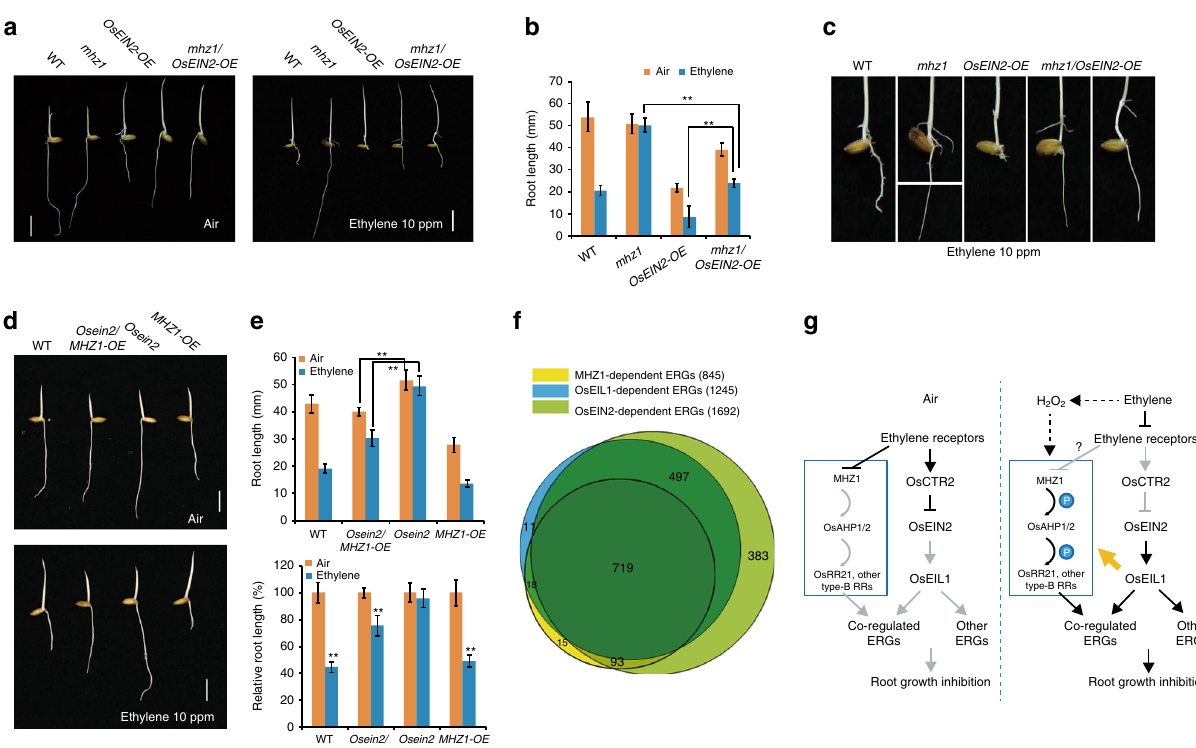
Fig. 5 Genetic interaction of MHZ1 and OsEIN2-mediated pathways. a Ethylene response of mhz1/OsEIN2-OE in comparison with mhz1 and OsEIN2-OE . Bars indicate 10 mm. b Quanti fi cation of root length of the mutants in a . Root lengths are means ± SD, n > 30. ** P < 0.01; Student ’ s t -test. c Enlargement of root features of the mutants treated with 10 ppm ethylene in a . d Ethylene response of Osein2/MHZ1-OE in comparison with Osein2 and MHZ1-OE . Rice seedlings were grown in dark for 2 days with air or 10 ppm ethylene. Bars indicate 10 mm. e Quanti fi cation of root length (above) and relative root length (below) of the mutants in d . Data are means ± SD, n > 30. ** P < 0.01; Student ’ s t- test. f Comparison of MHZ1-, OsEIN2-, and OsEIL1-regulated ethylene- response genes. Etiolated seedlings of WT, mhz1 , Osein2 and Oseil1 were grown for 2 days before treated with air or 10 ppm ethylene for 3 h. Roots were subjected to RNA-seq analysis with three biological replicates. Ethylene-response genes (ERGs) were identi fi ed in WT according to the gene expression levels with at least relative twofold changes ( q -value < 0.05) in ethylene treatment compared to those in the air. A total of 1789 ERGs were identi fi ed. g A proposed working model for MHZ1-mediated ethylene signaling in rice. Rice has the conserved components of ethylene signaling as those in Arabidopsis, including ethylene receptors, OsCTR2, OsEIN2, and OsEIL1. Besides the conserved receptor-CTR2-OsEIN2-OsEIL1 signaling pathway, our results suggests a novel MHZ1-AHP1/2-OsRR21 phosphorelay pathway, through which ethylene receptors could regulate the root growth of rice by suppressing the kinase activity of MHZ1. In the absence of ethylene, ethylene receptors are in active conformations, which may facilitate their interaction with MHZ1 and suppress MHZ1 activity. With ethylene, ethylene receptors possibly released the repression effect on MHZ1 and the phosphorelay pathway is activated. The MHZ1- mediated phosphorelay pathway and the OsEIN2-mediated pathway may work together to regulate a subset of downstream gene to modulate root growth. MHZ1 and OsRRs can also be transcriptionally induced by ethylene through the OsEIN2-mediated pathway, which may facilitate the maintenance of MHZ1- mediated signaling after activation. The orange arrow indicates transcriptional activation. In addition, H 2 O 2 may also function through MHZ1 to participate in the ethylene-regulated root growth. Source data are provided as a Source Data